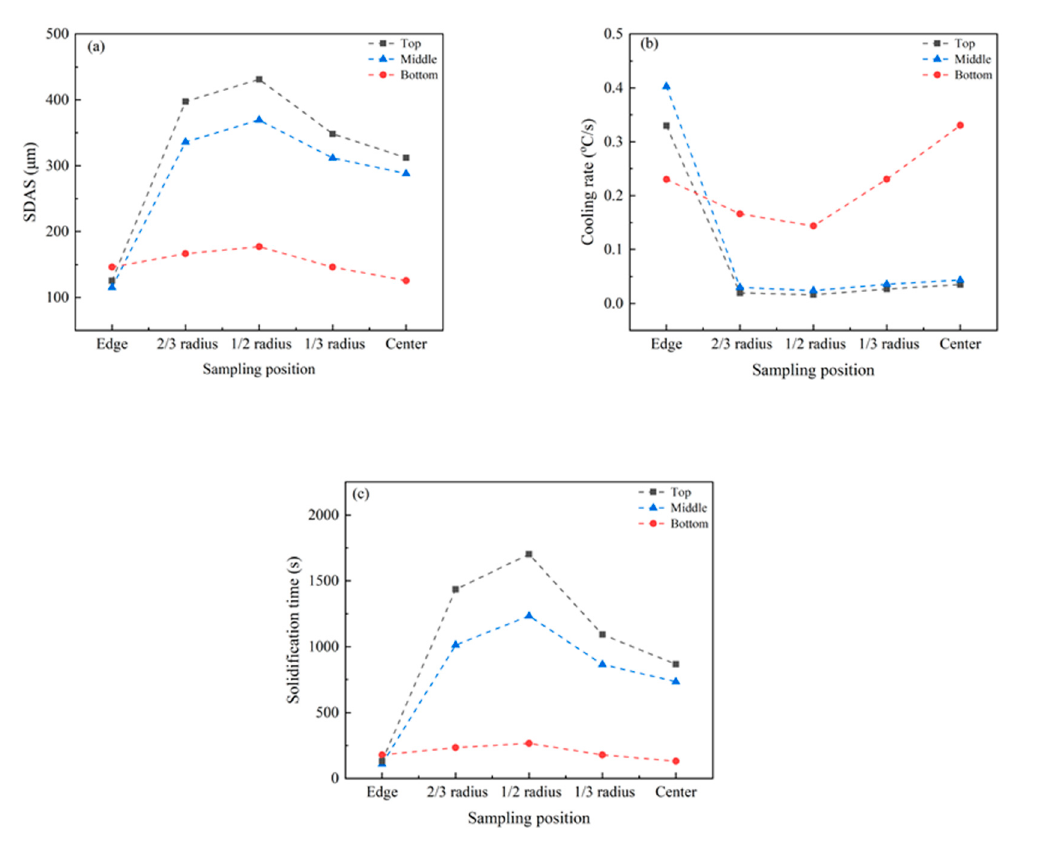
Figure 4. ( a ) Secondary dendritic arm spacing (SDAS), ( b ) cooling rate, and ( c ) solidification time at different positions of the ESR ingot. Table 3. Solidification front angle at different positions of the ESR ingot (degree).